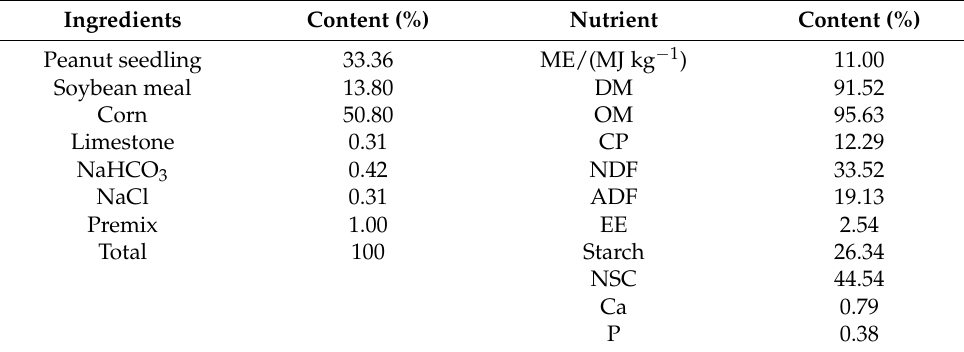
Table 1. Feed composition and nutrient levels of the feed (dry matter